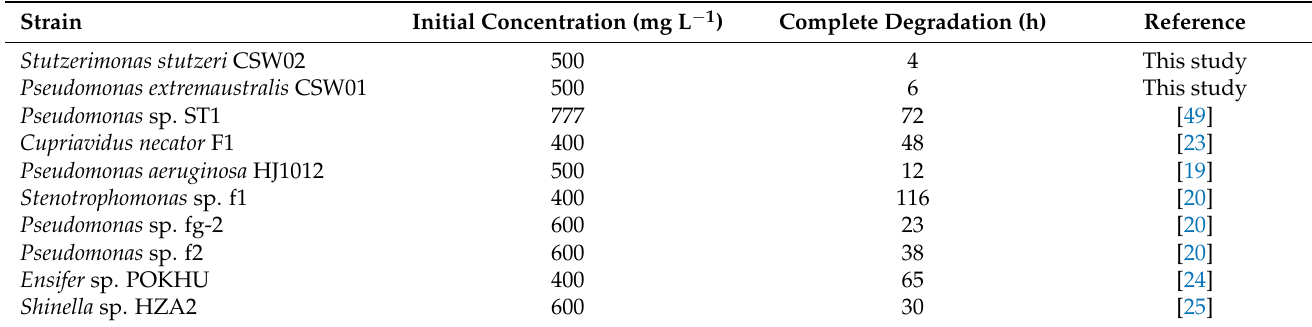
Table 5. Degradation of APAP by different bacterial strains under similar